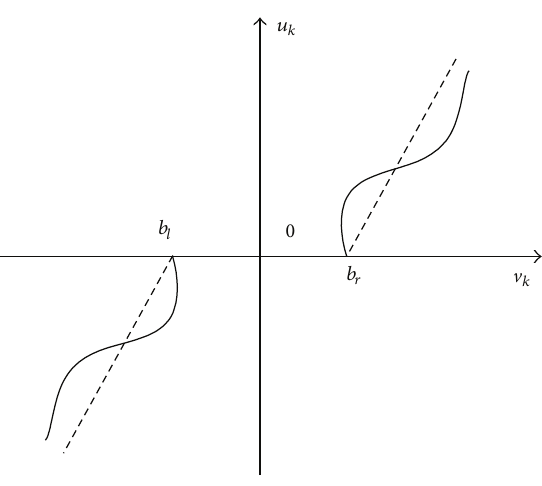
Figure 1: Dead-zone